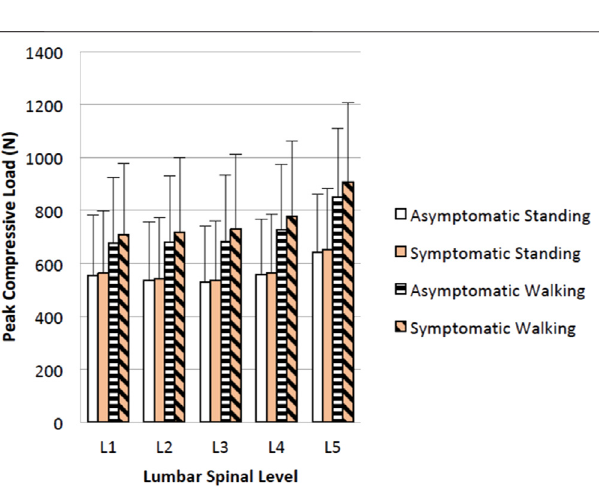
Frontiers in Bioengineering and Biotechnology |